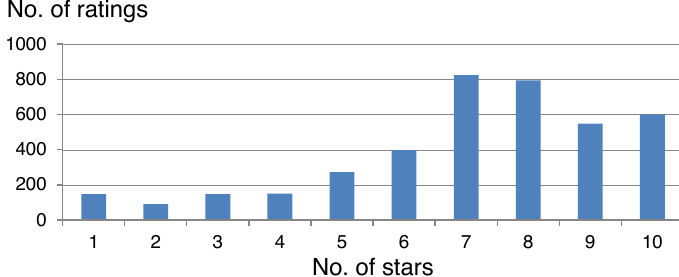
Figure 3. Star Trek television series episode IMDb user ratings distribution as of December